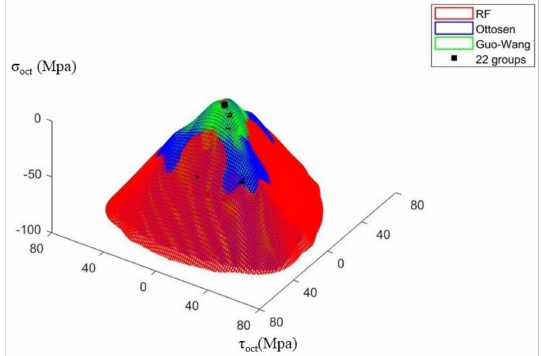
Figure 12. A 3D view of the failure surface.